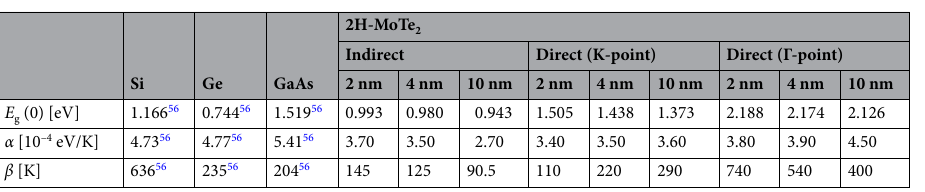
Table 1. Parameters of temperature-dependent